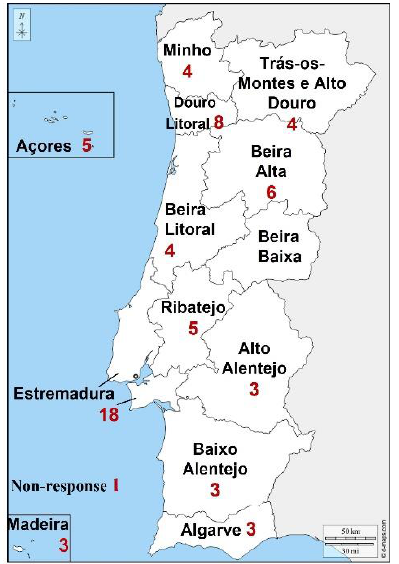
Figure 1. Geographical distribution of completed questionnaires (n = 67) directed to Animal shelters in Portugal in March/April 2021 (Map adapted from https://d-maps.com/carte.php?num_car=24972&lang=pt (accessed on 26 July 2021)).